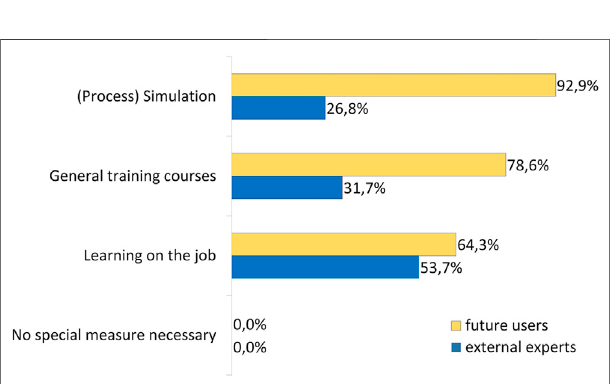
FIGURE 7 | Expected learning measures of future users and external experts (COCOP, own